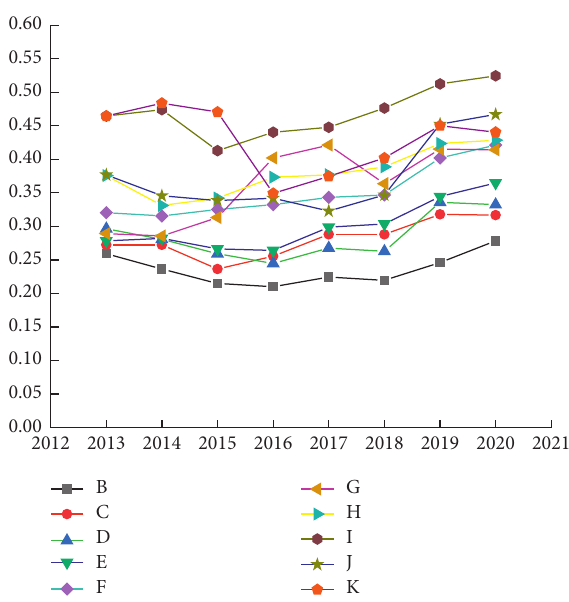
Figure 2: Comparison line chart of performance evaluation results of public